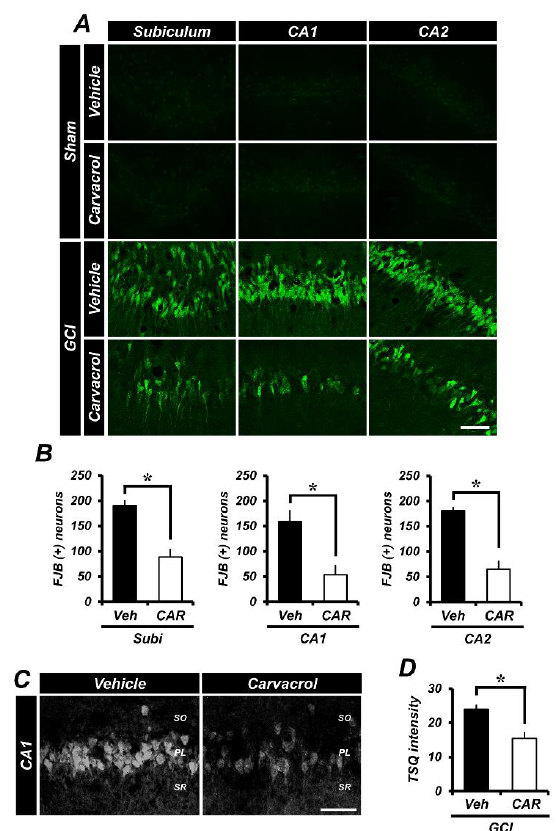
Figure 1. Carvacrol administration decreased degenerating neurons and hippocampal zinc accumulation after global cerebral ischemia (GCI). ( A ) Brain sections were stained with Fluoro-Jade B (FJB, green signal) to detect degenerating neurons in the hippocampal subiculum (Subi), Cornus Ammonis 1 (CA1), and Cornus Ammonis 2 (CA2) after GCI. There were no FJB-positive degenerating hippocampal neurons in the sham-operated groups. FJB-positive neurons were observed in the Subi, CA1, and CA2 of the hippocampus after GCI. Administration of carvacrol after GCI once per day for three days reduced FJB-positive neurons in the Subi, CA1, and CA2 regions. Scale bar = 50 µ m. ( B ) The counted FJB positive degenerating neurons. There was a statistically significant difference between the GCI vehicle group and the GCI carvacrol group in the Subi, CA1, and CA2 regions. When compared to the GCI vehicle group, the GCI carvacrol group shows reduced degenerating neurons. (GCI vehicle: n = 5; GCI carvacrol: n = 5). Data are the mean ± standard error of mean (SEM), * p < 0.01. ( C ) Zinc-specific N -(6-methoxy-8-quinolyl)- para -toluenesulfonamide (TSQ) fluorescence photomicrographs in the hippocampal CA1 region at three days after GCI. The bright white fluorescence signal indicates zinc accumulation. Zinc accumulation was higher in the GCI vehicle group. However, carvacrol treatment reduced zinc accumulation in the hippocampal CA1. Scale bar = 50 µ m. ( D ) Quantified TSQ fluorescence intensity signal (GCI vehicle: n = 4; GCI carvacrol: n = 4). Data are the mean ± SEM, * p <